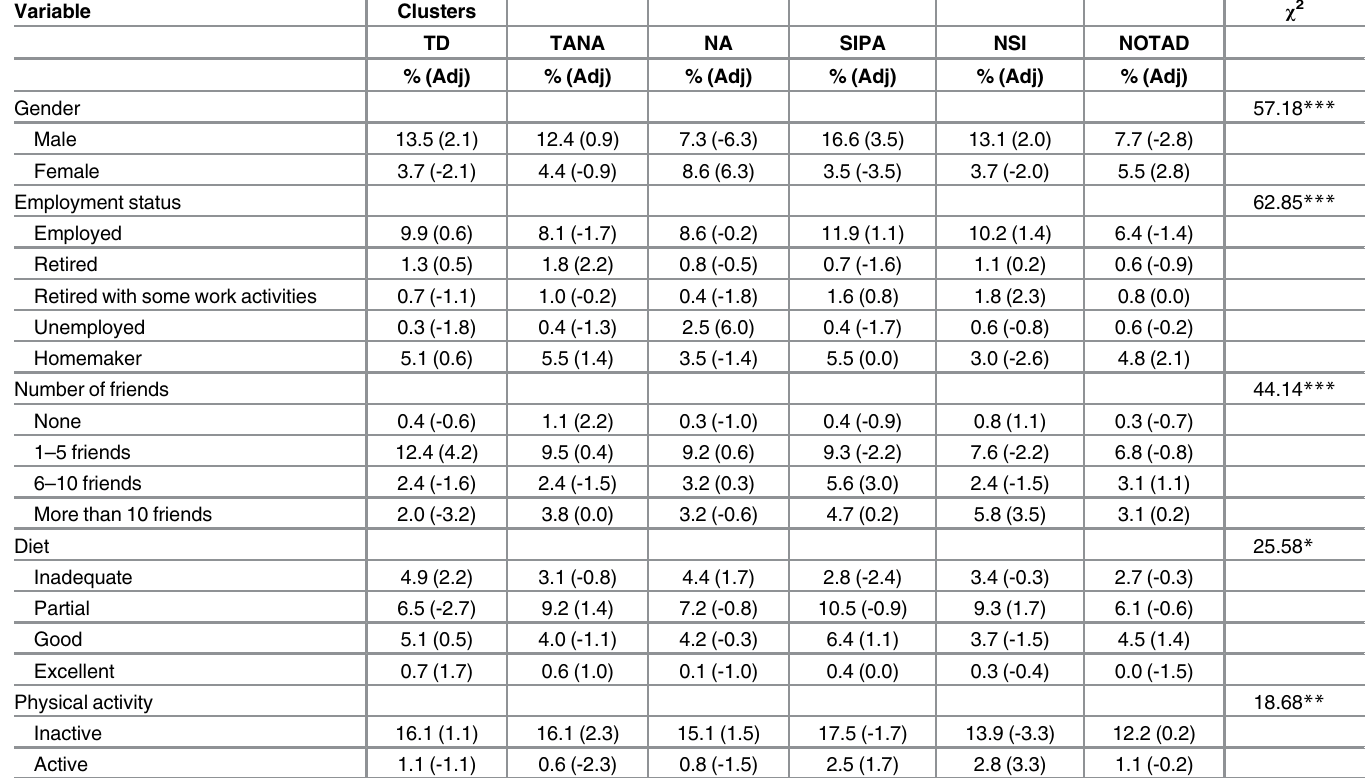
Table 4. Significant χ 2 analyses for the final six-cluster solution for gender, employment status, number of friends, diet and physical activity: per- centages and adjusted